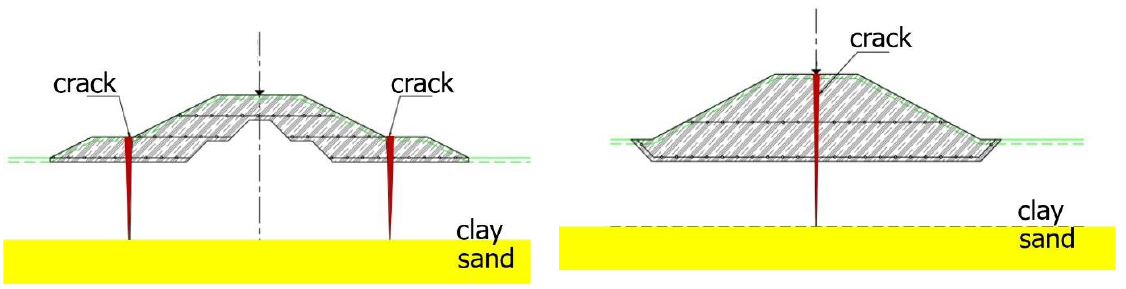
Figure 11. Embankment reconstruction where cracks have opened through the embankment body: the embankment needs to be removed and reconstructed with geogrid reinforcements for better performance in future earthquakes.